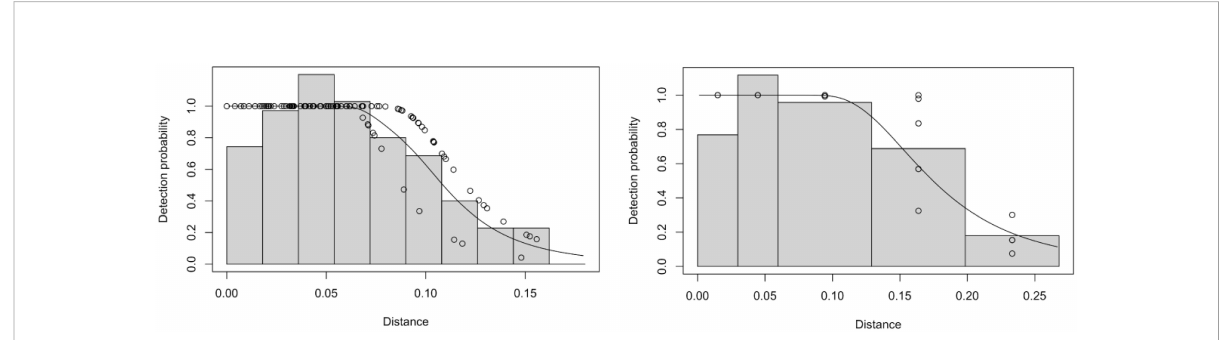
FIGURE 4 Detection probability functions fi t to perpendicular distance (in kilometer) data collected in Babitonga Bay, southern Brazil, in February 2011, by the boats (left) and the aircraft